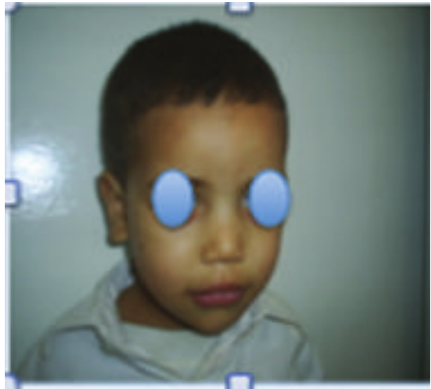
Figure 3: Case 2: hypertelorism.